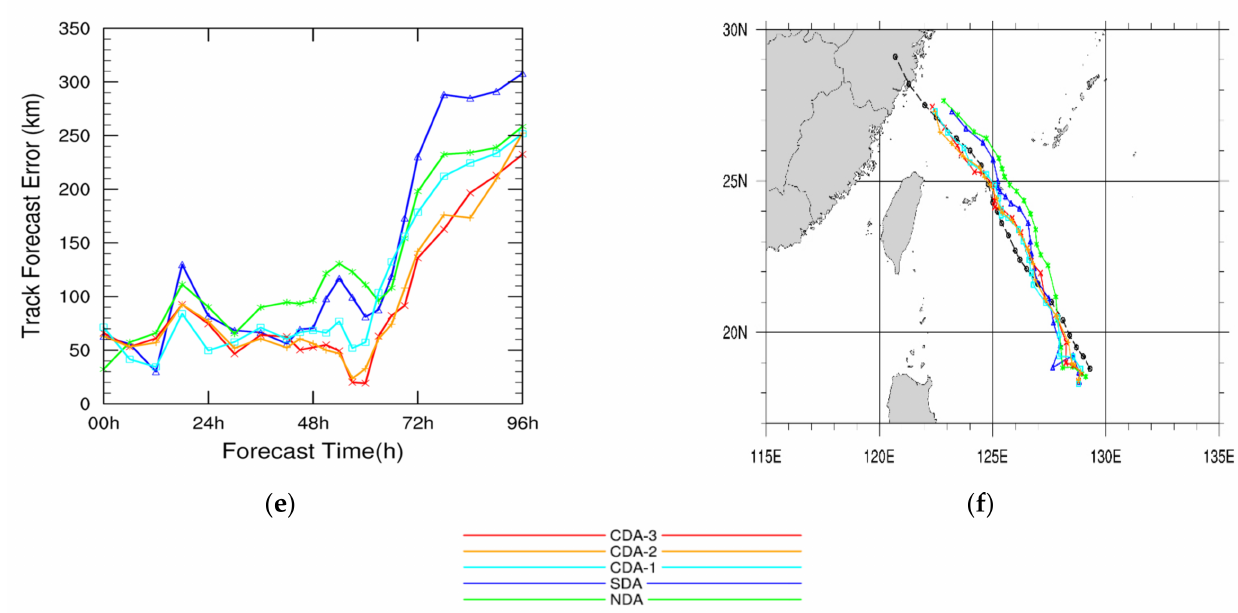
Figure 11. The predicted ( a ) minimum surface level pressure (hPa) and ( b ) its error (hPa). The predicted ( c ) maximum wind speed (m/s) and ( d ) its error (m/s). The predicted ( e ) track errors and ( f ) track of Lekima initialized from 0000 UTC 6 August 2019. The black line in ( a , c , f ) represent the best track